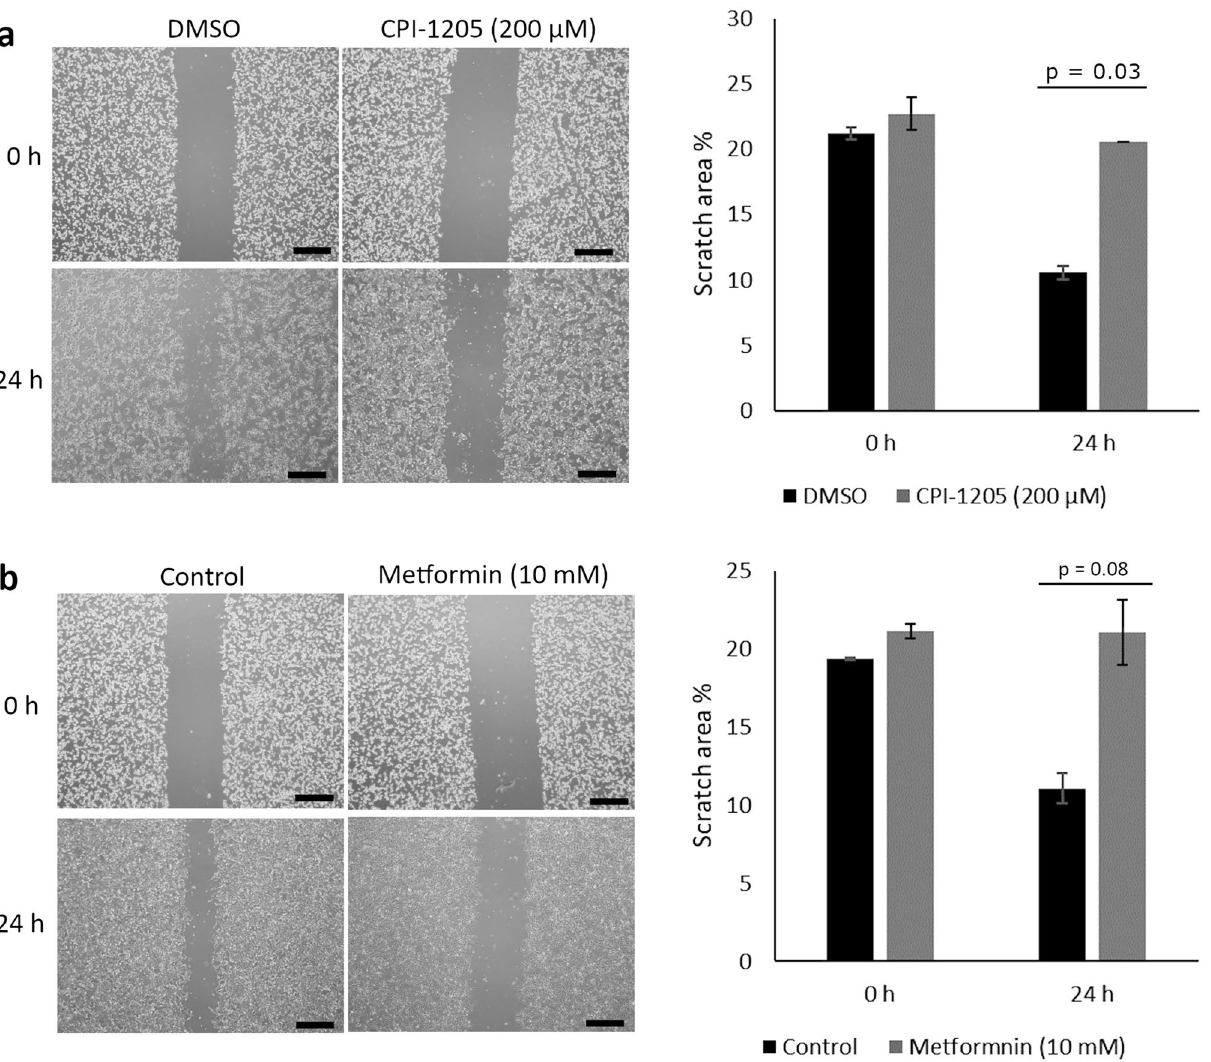
Figure 7. Effects of CPI-1205 and metformin on migration of SI-NET cells. Migration of CNDT2.5 cells was measured by scratch wound-healing assay following incubation with ( a ) 200 µM CPI-1205 or ( b ) 10 mM metformin. Representative bright-field images and quantification of scratch wound area at 0 and 24 h after treatment are shown. Scale bar 500 µm. Data presented are means ± SD of